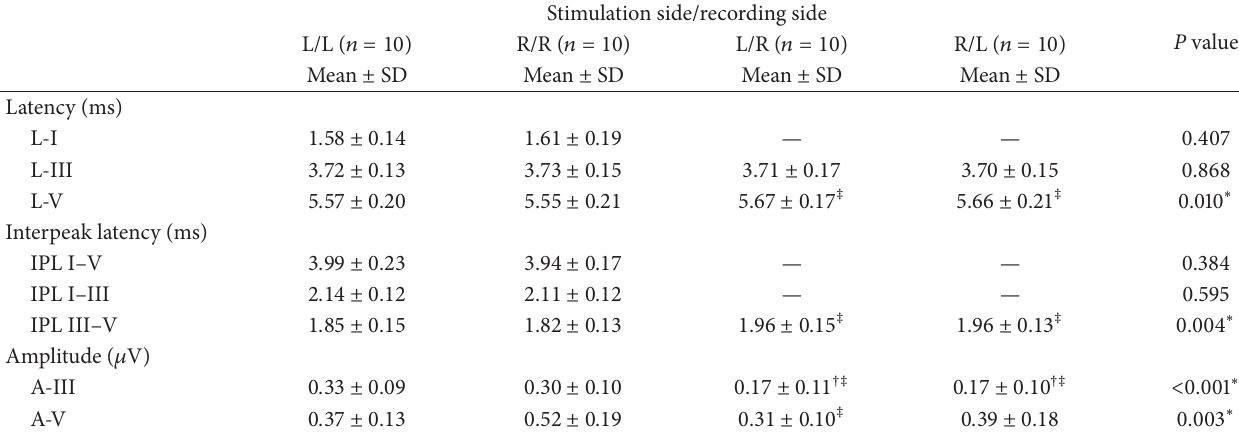
Table 2: Absolute latency, interpeak latency, and wave amplitude in control subjects.